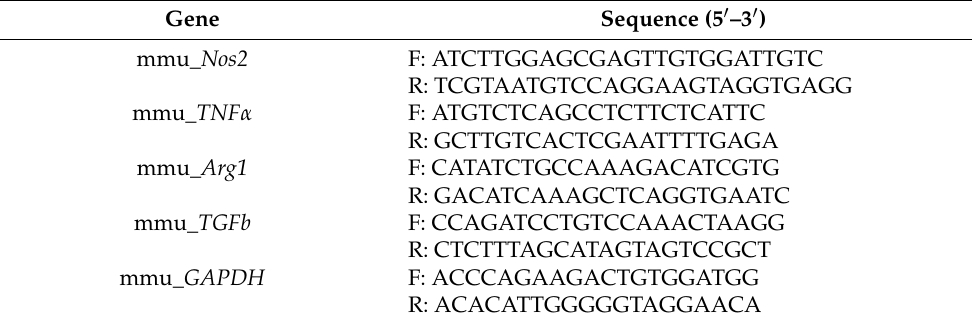
Table 1. Primers used for